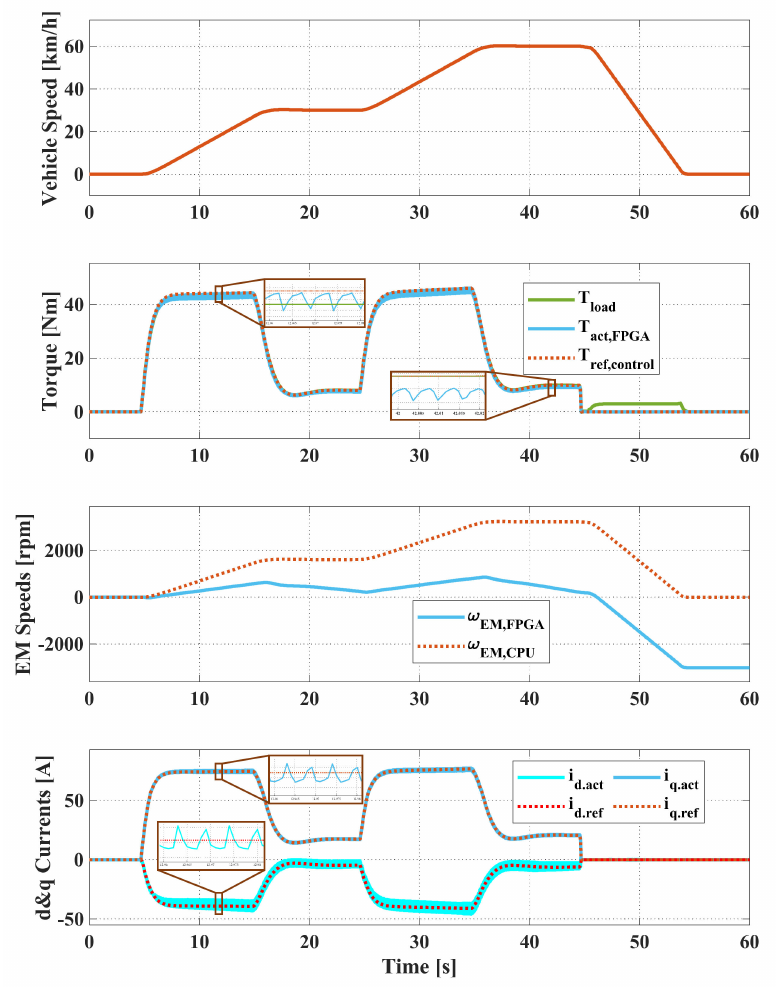
Figure 7. Open-loop real-time simulation